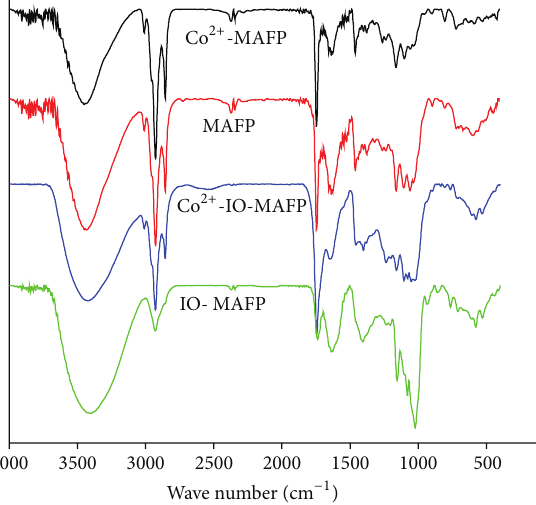
Figure 4: FT-IR spectrum of biomasses, MAFP, and IO-MAFP before and after Co(II) loaded.